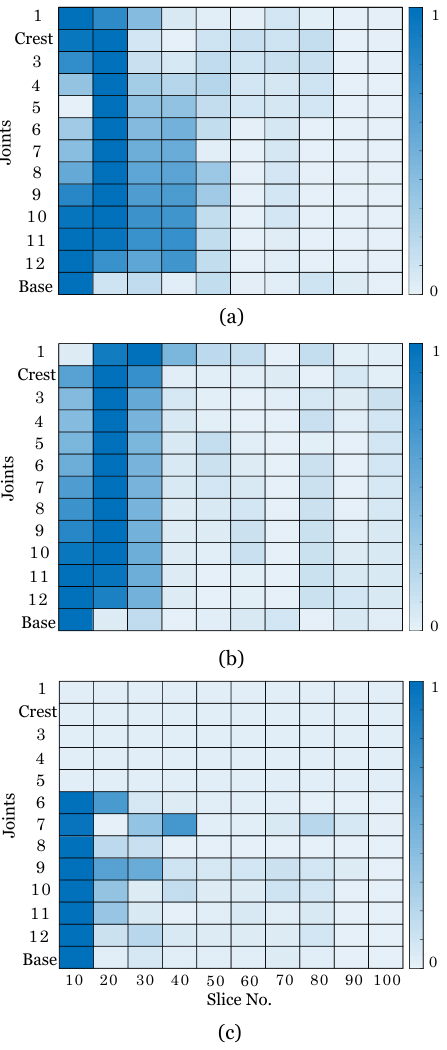
Figure 10. Progressive Latin hypercube sampling (PLHS) slice iterations: ( a ) E µ − SSF , ( b ) E σ − SSF ,